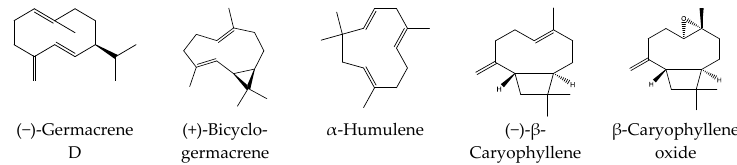
Figure 1. Chemical structures of sesquiterpenes (−)-germacrene D, (+)-bicyclogermacrene, α-humulene, (−)-β-caryophyllene, and β-сaryophyllene oxide.